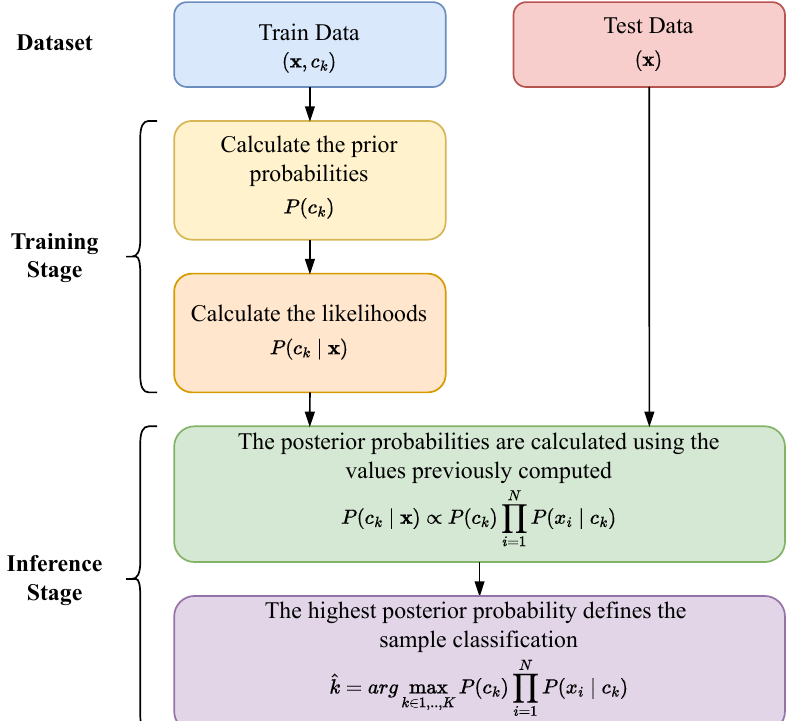
Figure 1. Flowchart for the Naive Bayes